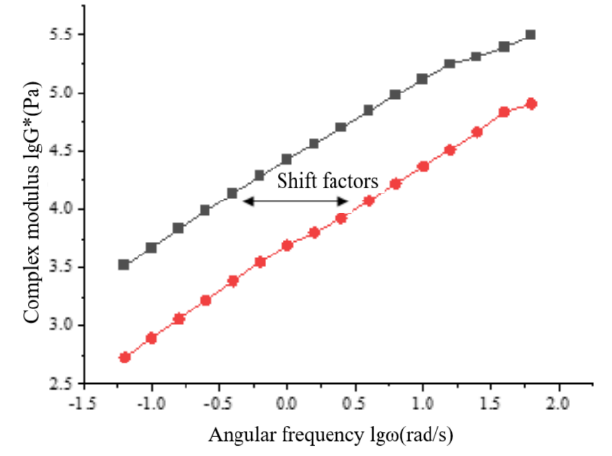
Figure 4. Schematic diagram of displacement factor. (Black line: the lgG*-lg ω curve of the frequency sweep test of the asphalt sample at 40 °C, which is defined as the reference temperature line. Red line: lgG*-lg ω curve of asphalt sample at other temperatures except the reference temperature